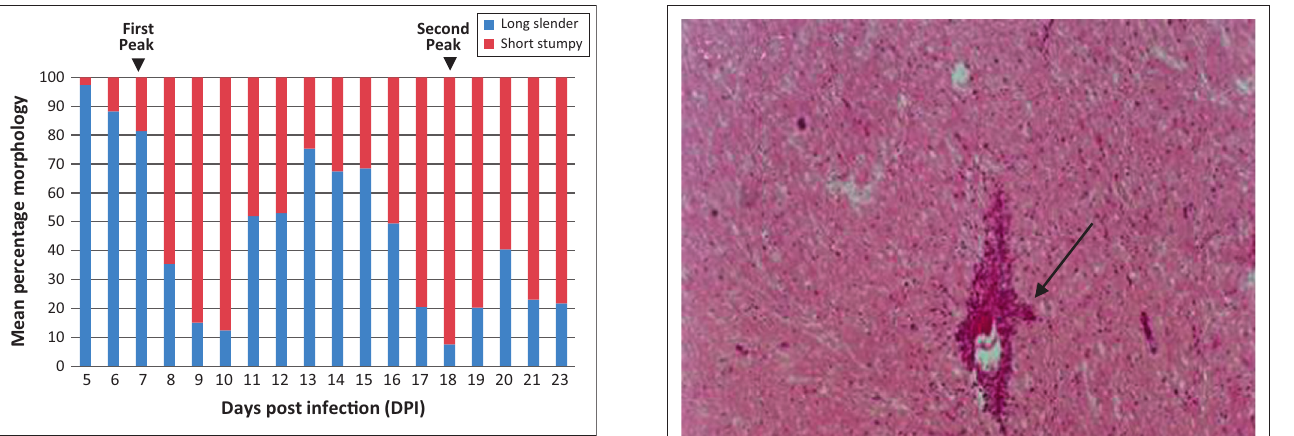
FIGURE 5: Parasite morphology pattern for ILRI-2918 infection in Swiss white mice. During the first parasitaemia peak at seven DPI, there was an increase in short stumpy forms (18.6 % ) with a decline in long slender forms (83.7 % ). At the second peak at 17–19 DPI, there was a predominance of short stumpy forms (up to 92.4 % ) and a decline of long slender forms (7.6 % ).